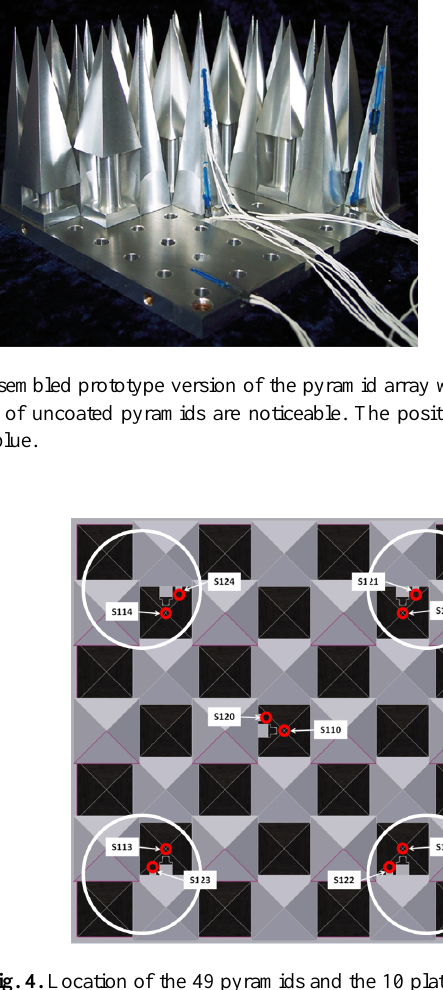
Fig. 4. Location of the 49 pyramids and the 10 platinum resistance thermometers (S110 to S114 and S120 to S124) on the radiating optical surface of a GLORIA blackbody. The white circles represent the field-of-view of the corner pixels of the GLORIA detector array.